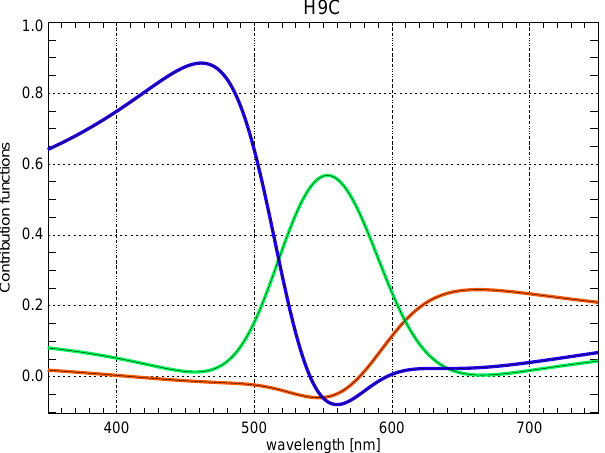
Figure 9. Contribution functions ( D ) for the ICX285AQ with smoothing parameter µ =